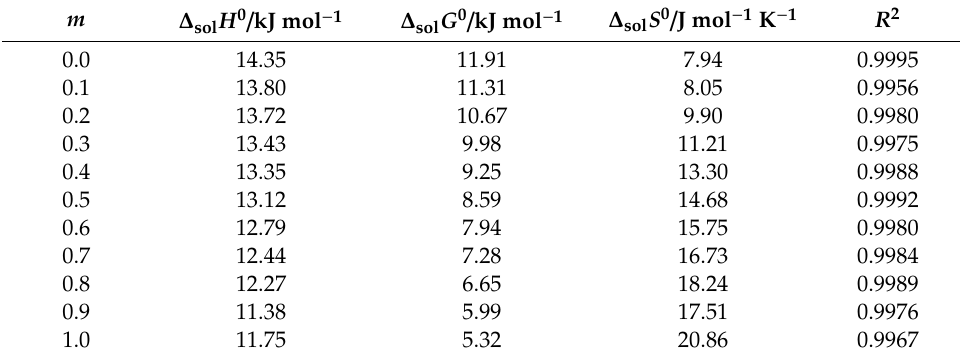
Table 4. Apparent thermodynamic parameters [apparent standard enthalpy ( ∆ sol H 0 ), apparent standard Gibbs energy ( ∆ sol G 0 ) and apparent standard entropy ( ∆ sol S 0 )] and R 2 values for ECT dissolution in various “PEG-400 + water” mixtures ( m ) b